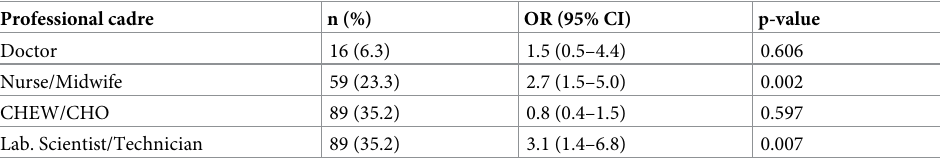
Table 3. Utilisation of malaria rapid diagnostic test among healthcare workers in selected health facilities, Zam- fara state (N =